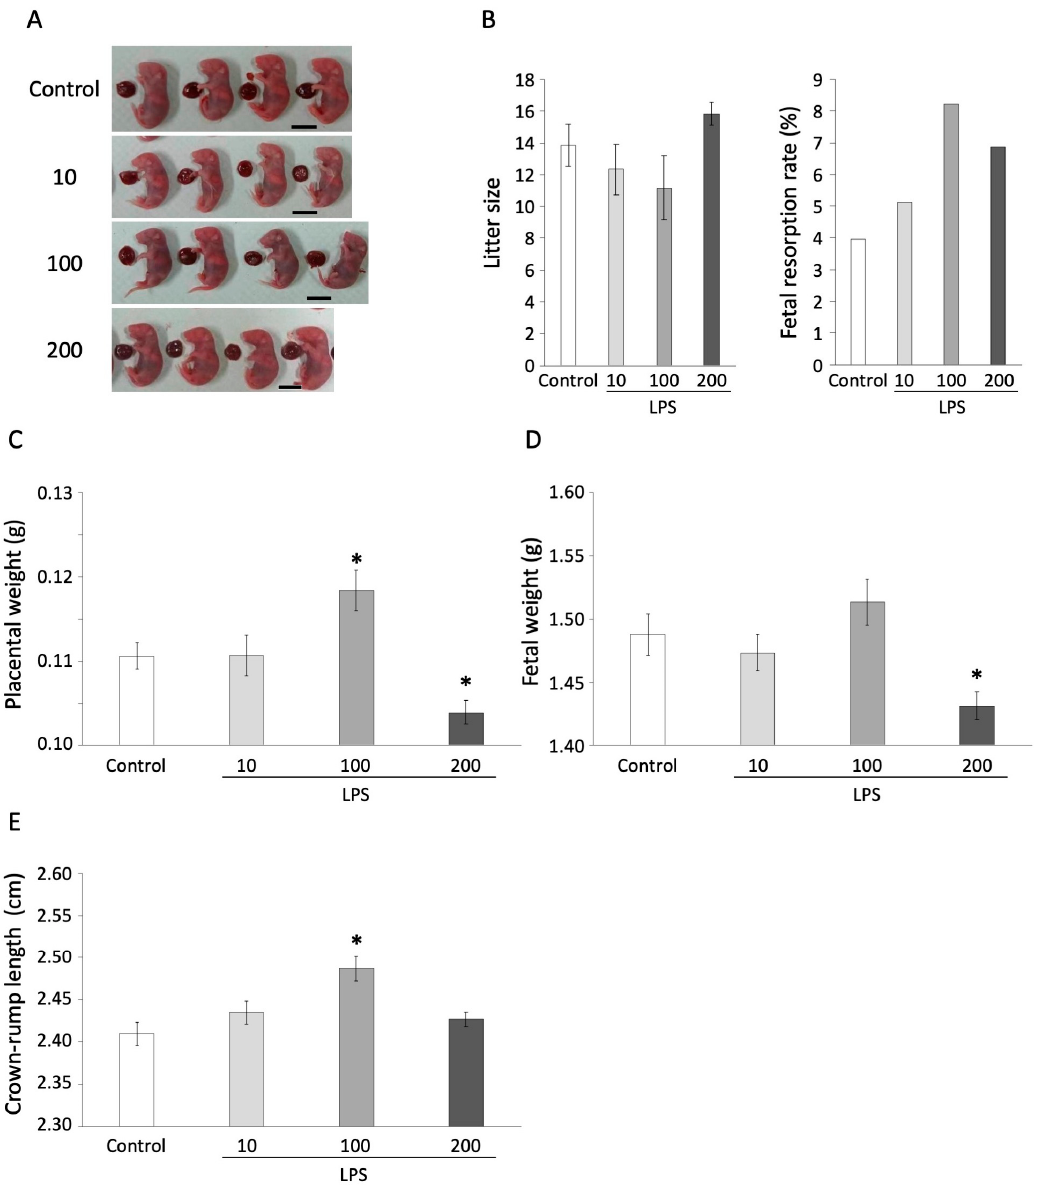
Figure 3. Effect of LPS for fetal development. Mice were administered 0, 10, 100, or 200 µ g/kg LPS at 0.5 dpc (control n = 7, each LPS group n = 6). The fetal parameters were measured at 18.5 dpc. ( A ) Appearance of the litters in each group. ( B ) Litter size and fetal resorption rate. ( C ) Placental weight. ( D ) Fetal weight. ( E ) Crown–rump length. The values are shown as mean ± SEM (control n = 97, 10 µ g/kg LPS n = 74, 100 µ g/kg LPS n = 67, 200 µ g/kg LPS n = 95) and * p <